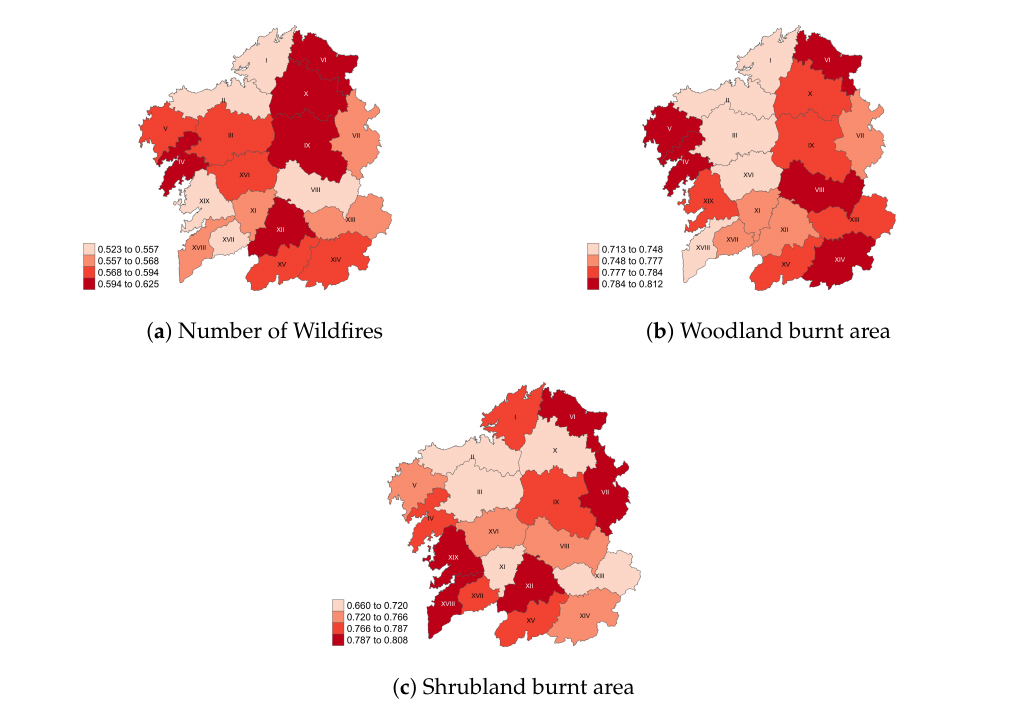
Figure 12. Average inequality indices G i for each of the Galician forest districts, clustered per